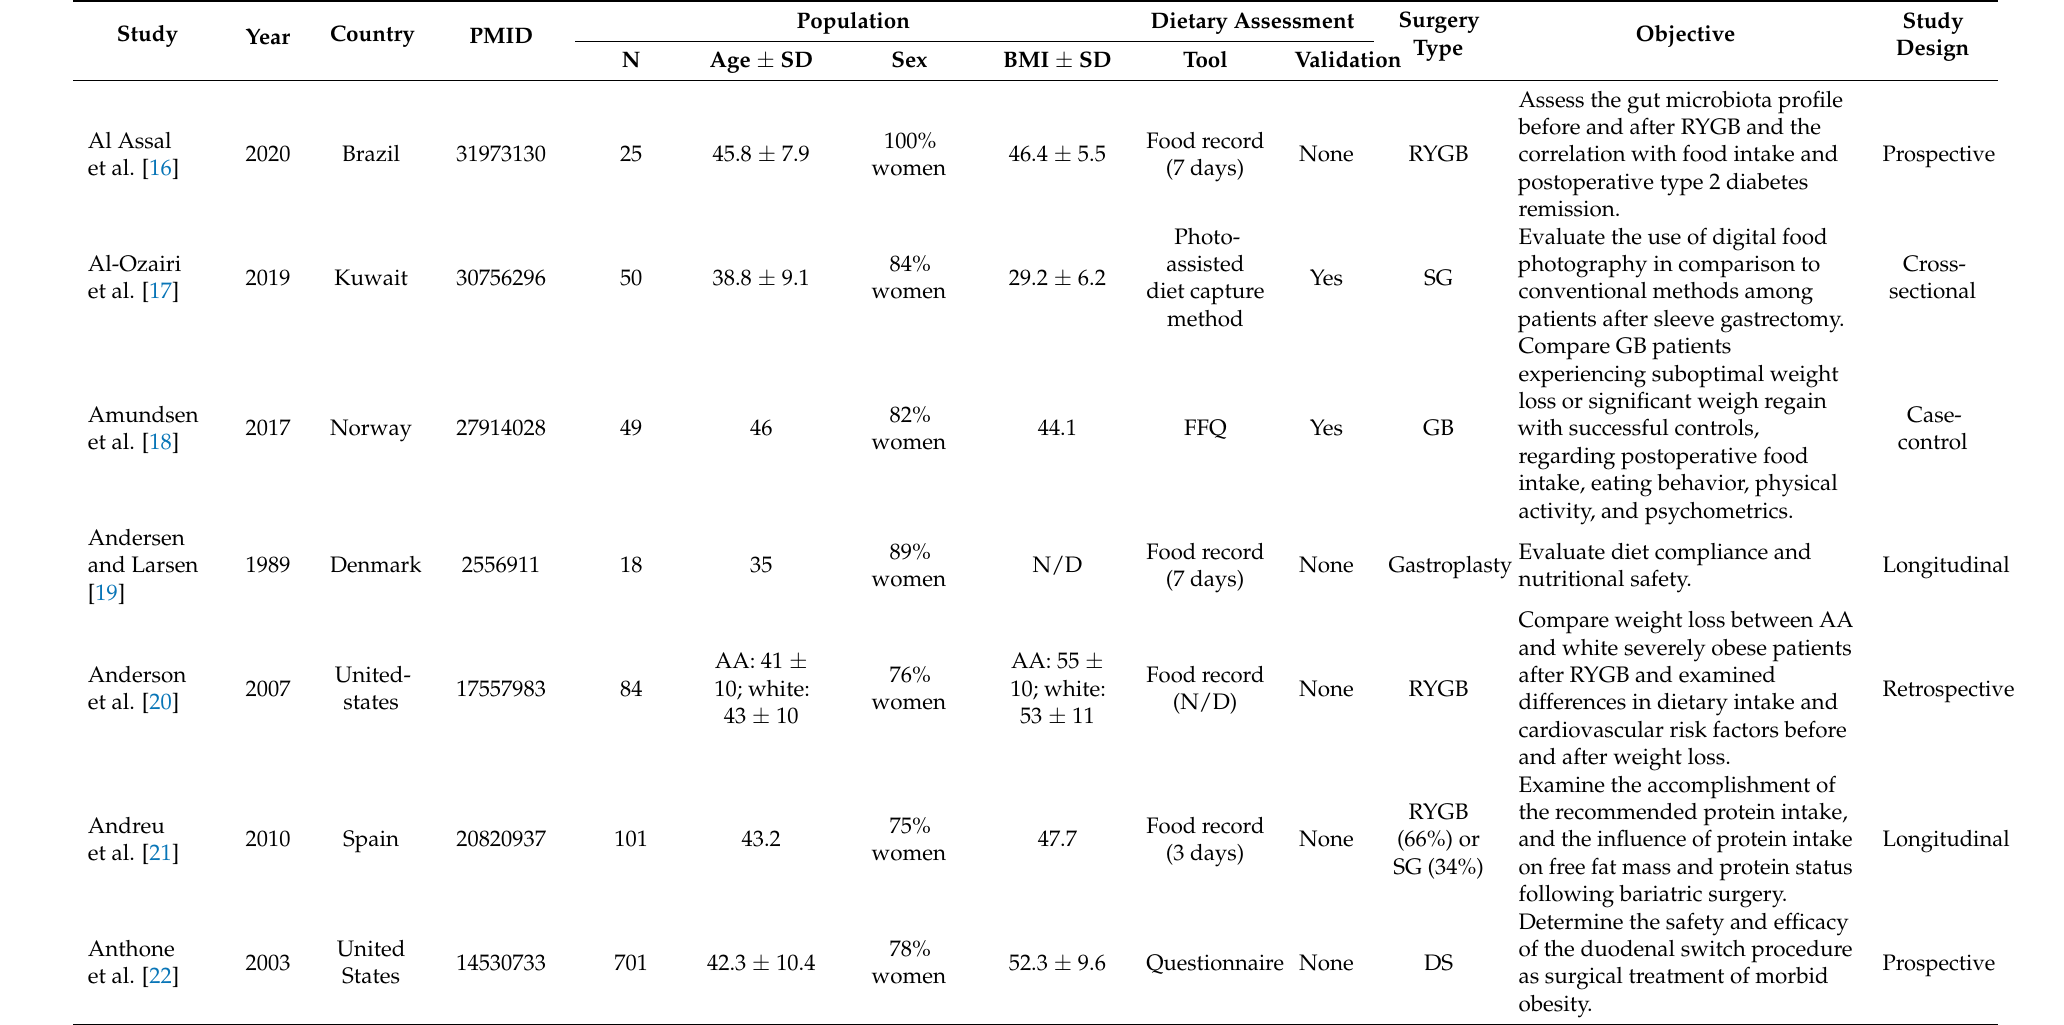
Table 2. Exhaustive description of included